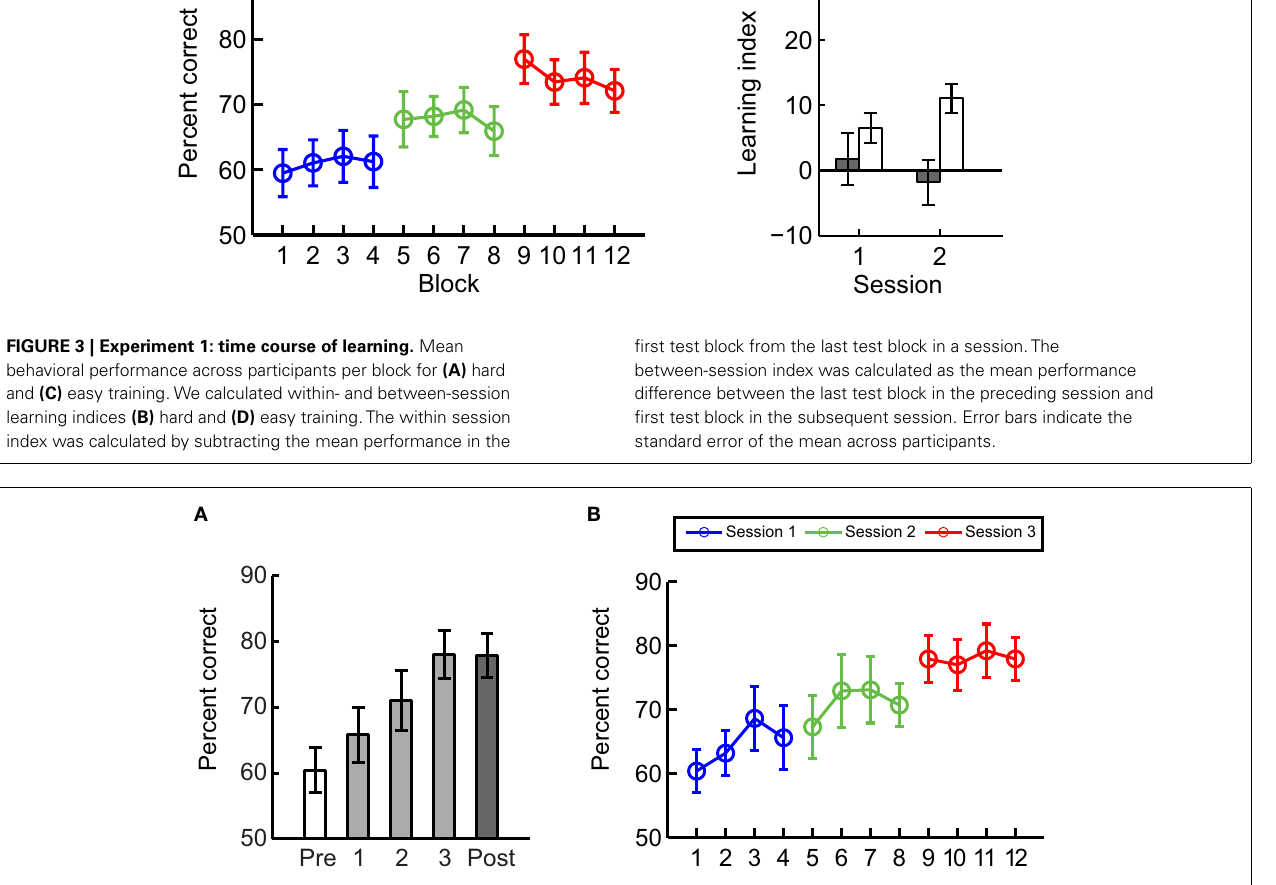
FIGURE 4 | Experiment 3. Mean performance across participants per (A) session and (B) block when participants were trained with stimuli at spiral angles of 40˚ vs. 50˚ that differed from the test stimuli (35˚ vs. 55˚). Error bars indicate the standard error of the mean across